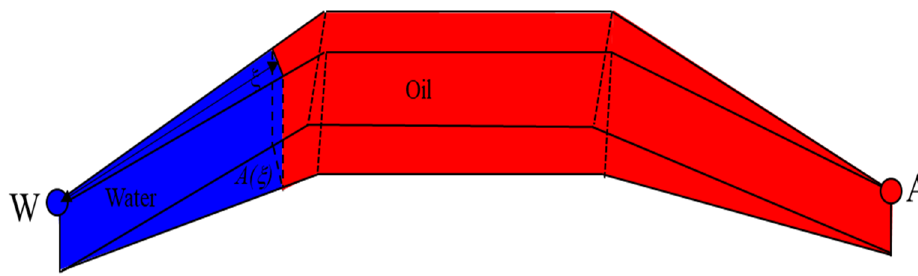
Figure 1. Enhanced oil recovery mechanism schematic diagram of polymer microsphere.